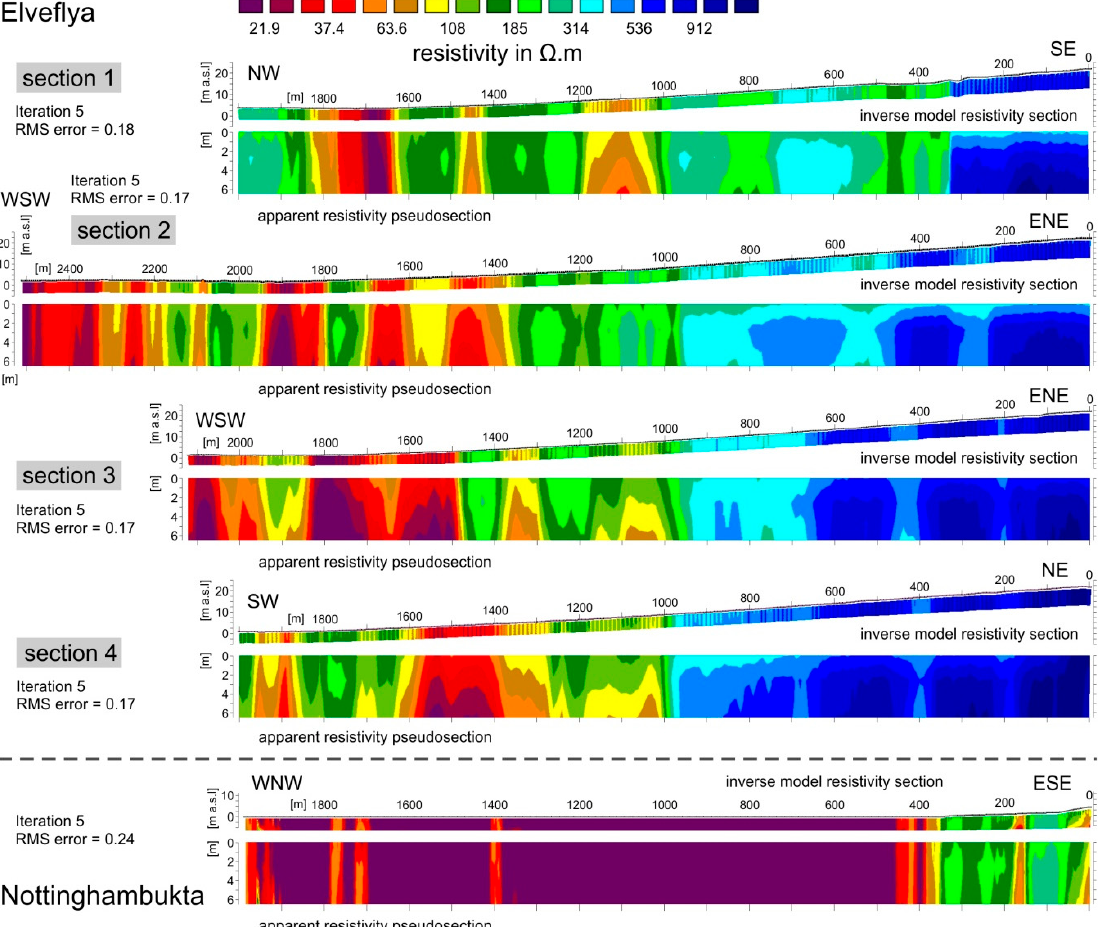
Table 5. Main features of Elveflya and Nottingham outwash fans.